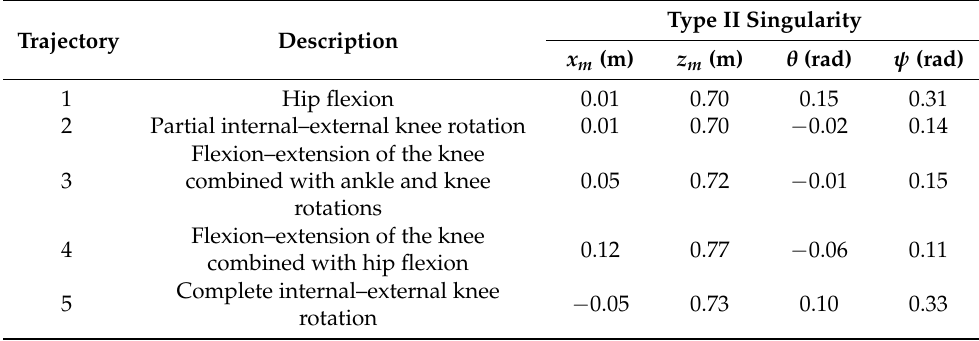
Table 3. Description of the trajectories with a type II singularity at the end.